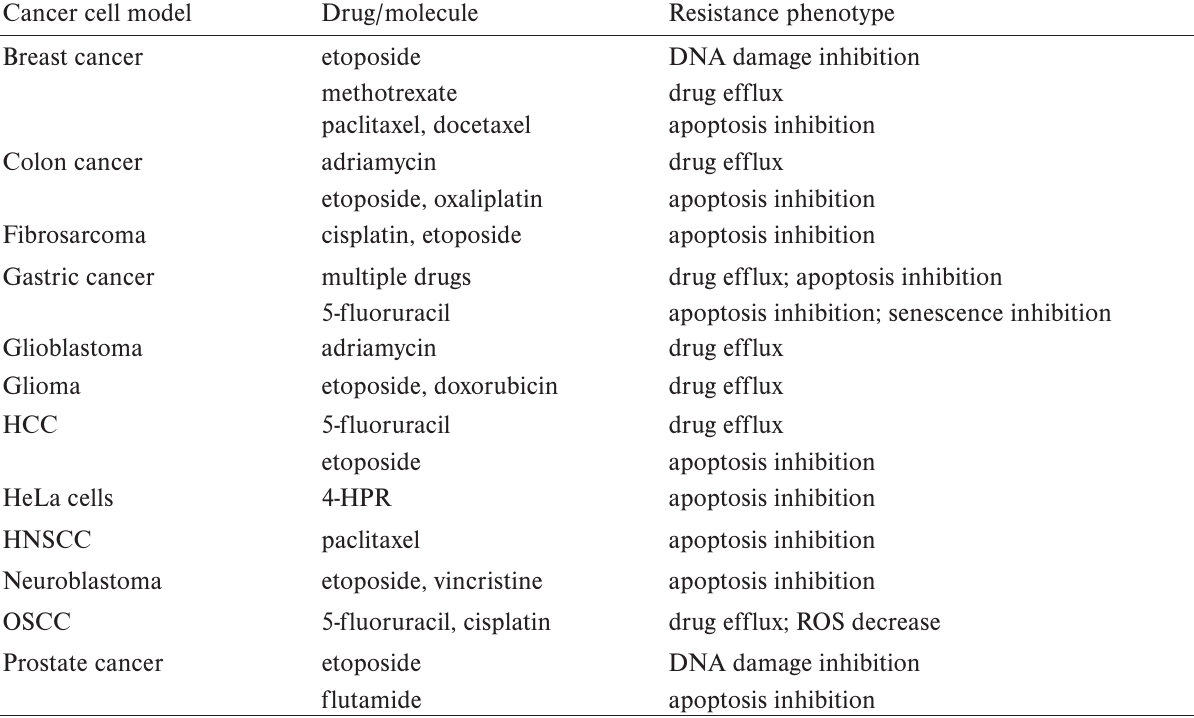
Table 3. Overview of HIF-1 mediated drug resistance mechanisms (modified according to ref. 32